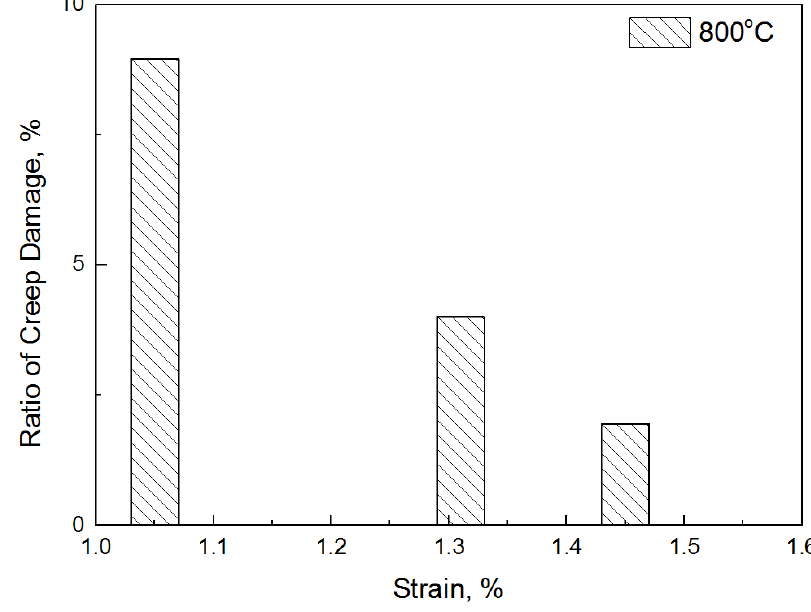
Figure 10. Ratio of damage caused by creep ( Σ D creep ) at 800°C.